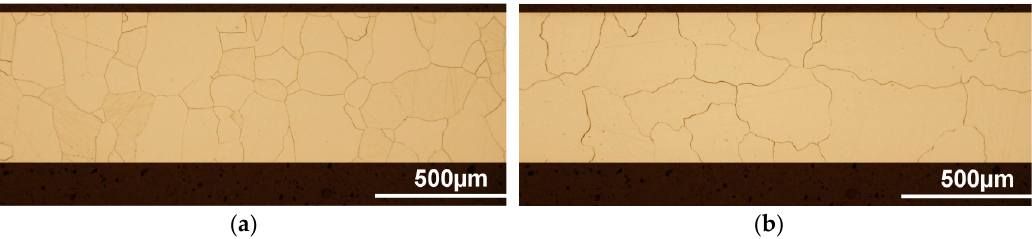
Figure 5. The microstructure of experimental stator segments after: conventional long-term heat treatment ( a ) and unconventional short-term dynamic heat treatment ( b ).